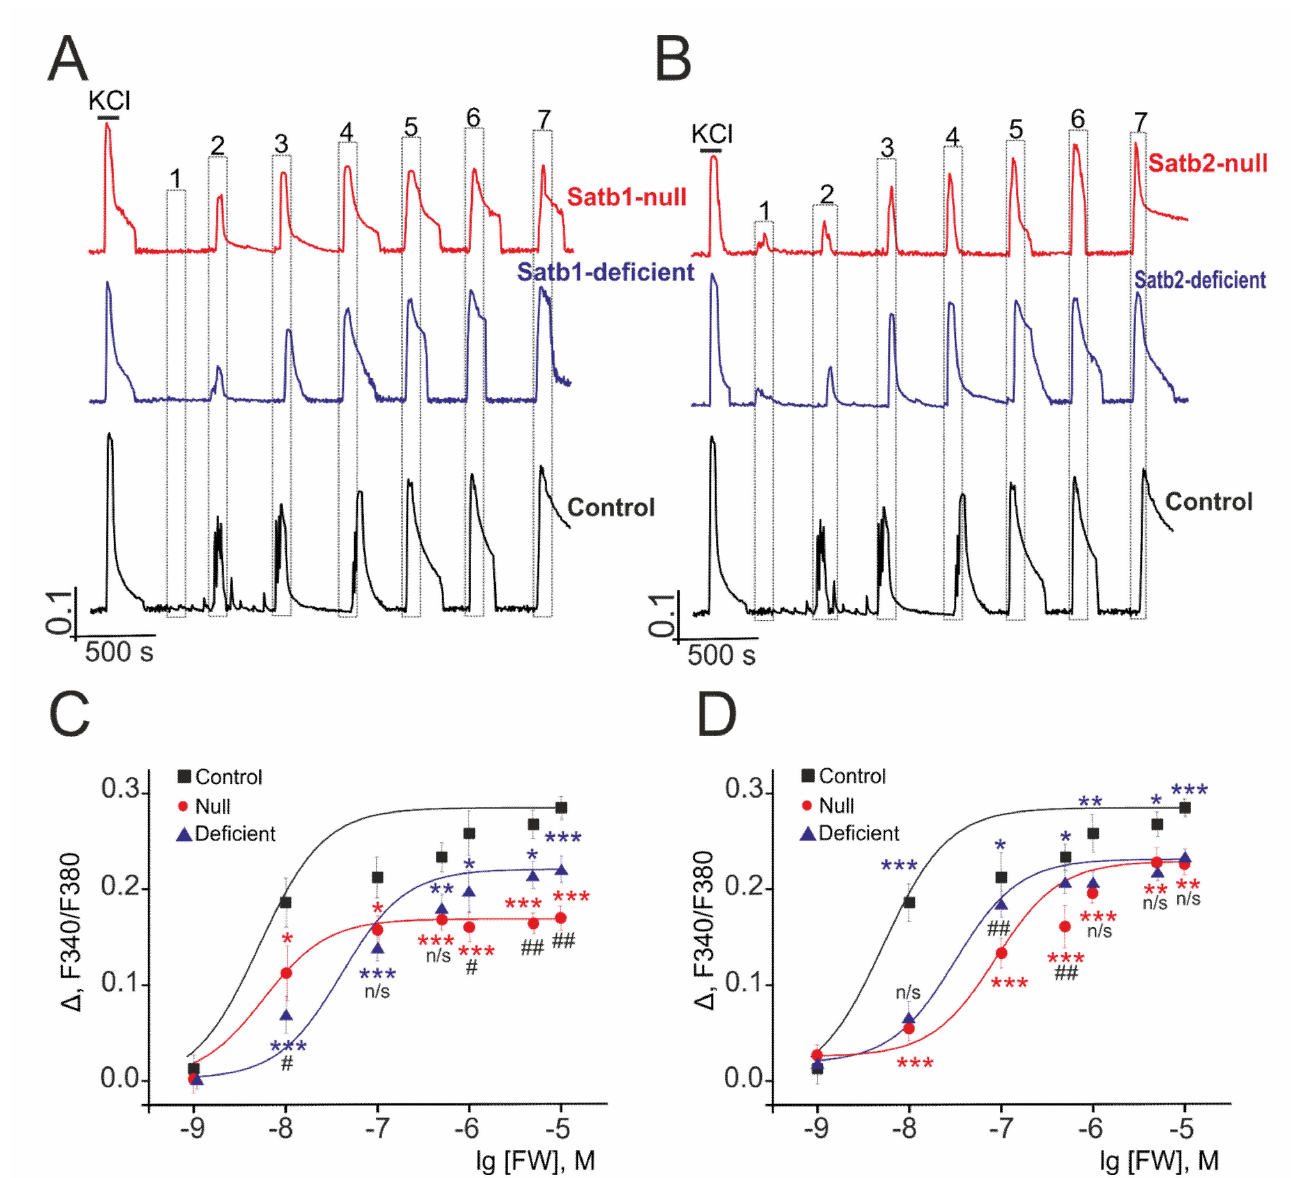
Figure 5. The effect of deletion in the transcription factors Satb1 and Satb2 on the Ca 2+ -signals produced by cortical neurons after activation of AMPA receptors. ( A , B )—application of enhancing FW concentrations in the presence of an inhibitor for desensitization of the AMPA receptors, cyclothiazide (CTZ, 5 µ M), to the neurons of brain cortex isolated from the Satb1 ( A ) and Satb2 ( B ) knockout mice. ( C , D )—dependence of the Ca 2+ -responses amplitude on FW concentration in the cortical neurons from Satb1 ( C ) and Satb2 ( D ) knockout mice. FW concentrations are specified with horizontal lines accompanied with correspondent cyphers: 1–0.001, 2–0.01, 3–0.1, 4–0.5, 5–1, 6–5, 7–10 µ M. For each concentration, average data are represented, obtained from several hundreds of neurons in 5 independent experiments ± SEM. For panels ( A , B ), averaged Ca 2+ -responses for neurons from individual experiments are represented. For panels ( A , B ), we analyzed 200 cells ( n = 200) in each experiment. For panels ( C , D ), every experiment was repeated five times ( n = 5) using cell cultures from separate passages. Statistical analyses were performed by two-way ANOVA, followed by Sidak’s multiple comparison test. * p < 0.05, ** p < 0.01, and *** p < 0.001 comparing Satb-deficient group (blue asterisk) and Satb-null group (red asterisk) with control group; # p < 0.05 and ## p < 0.01 comparing Satb-deficient group with Satb-null group; n/s (blue) and n/s (black)—data not significant in experimental Satb-deficient group compared to control group, and Satb-deficient group compared to Satb-null group,